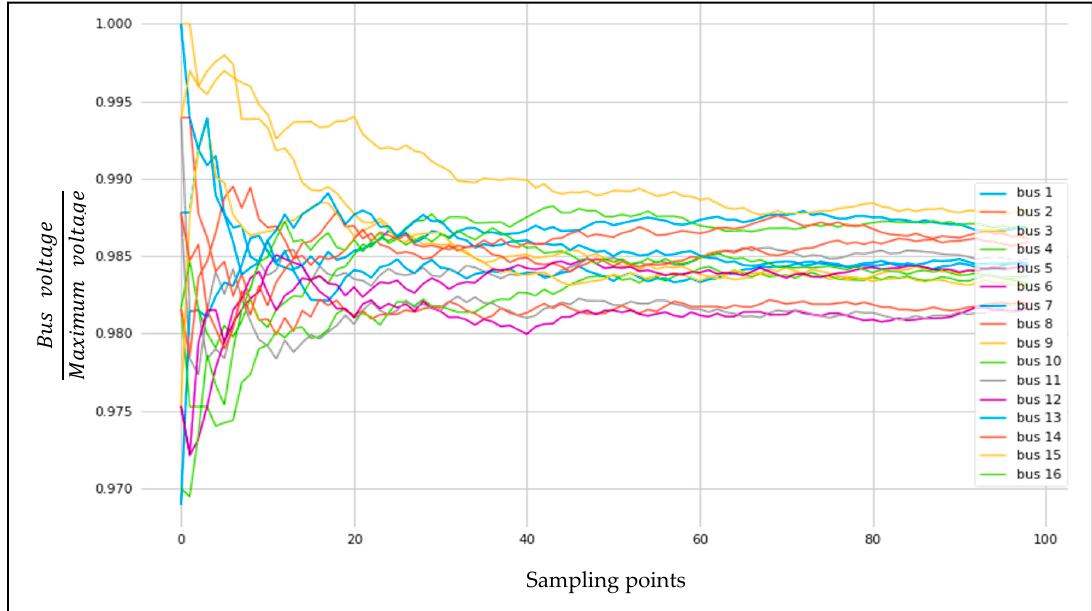
Figure 13. Monte Carlo bus voltage average for NASA N3-X under the cruising condition.